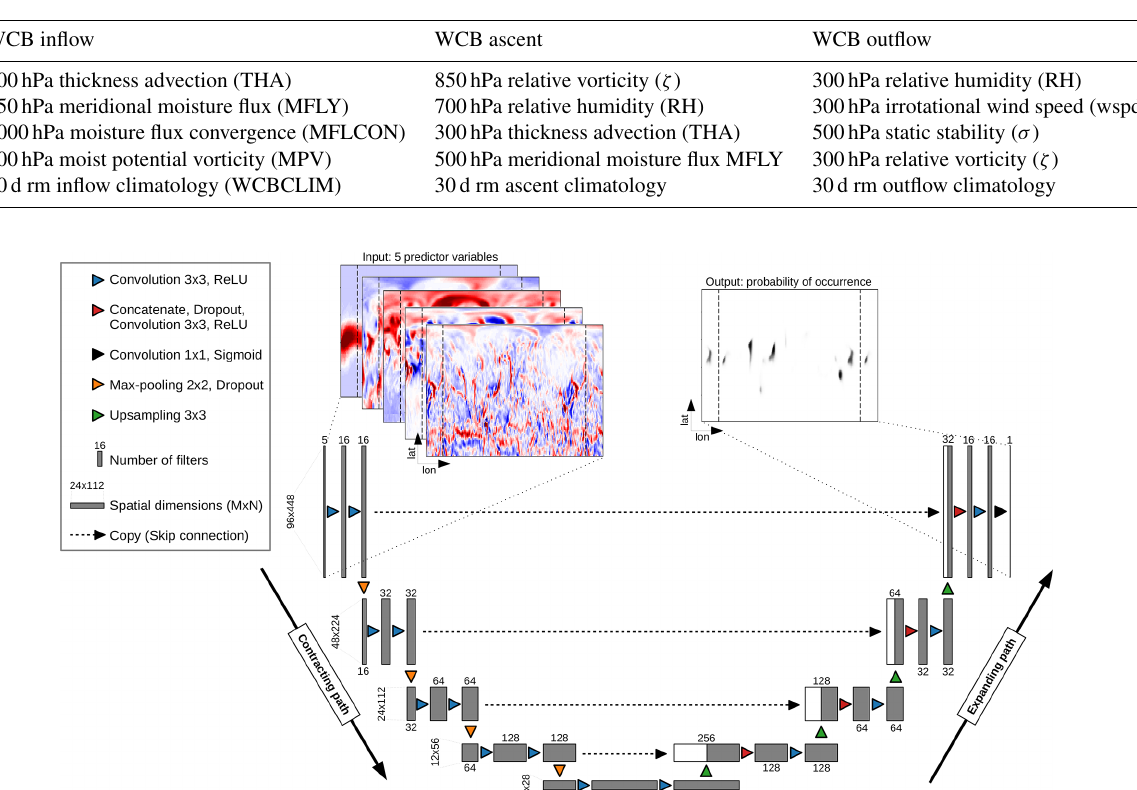
Table 1. The most important predictors for WCB inflow, ascent, and outflow as identified by Quinting and Grams (2021b). These predictors are used in the CNN standard models. The abbreviations P and rm stand for predictor and running mean, respectively.